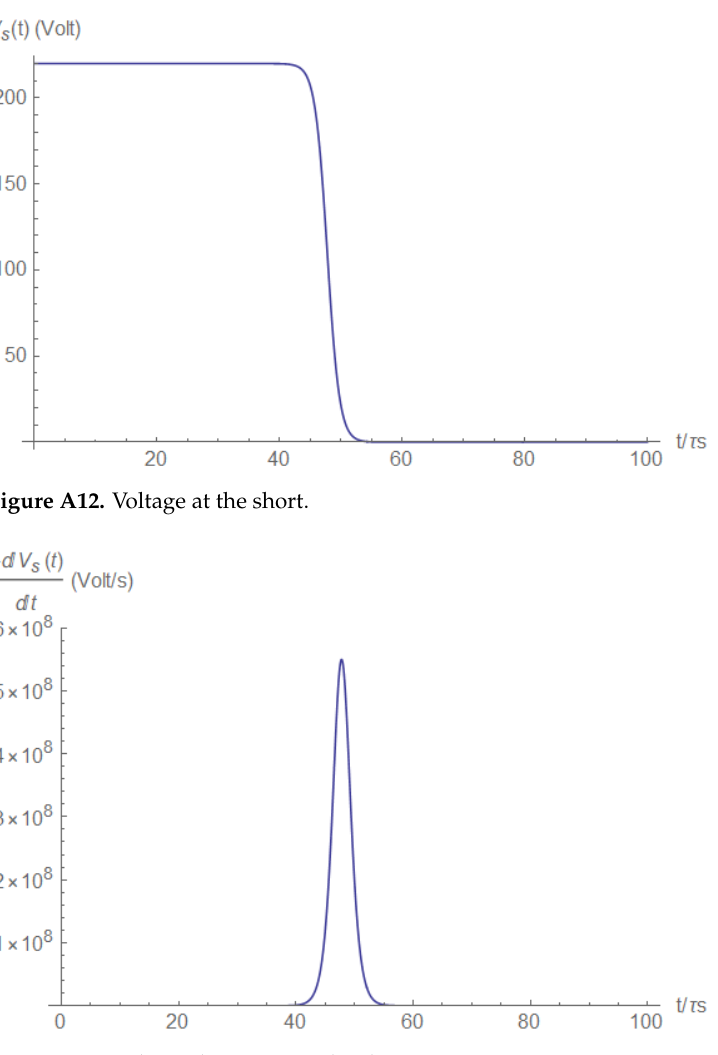
Figure A13. Voltage derivative at the